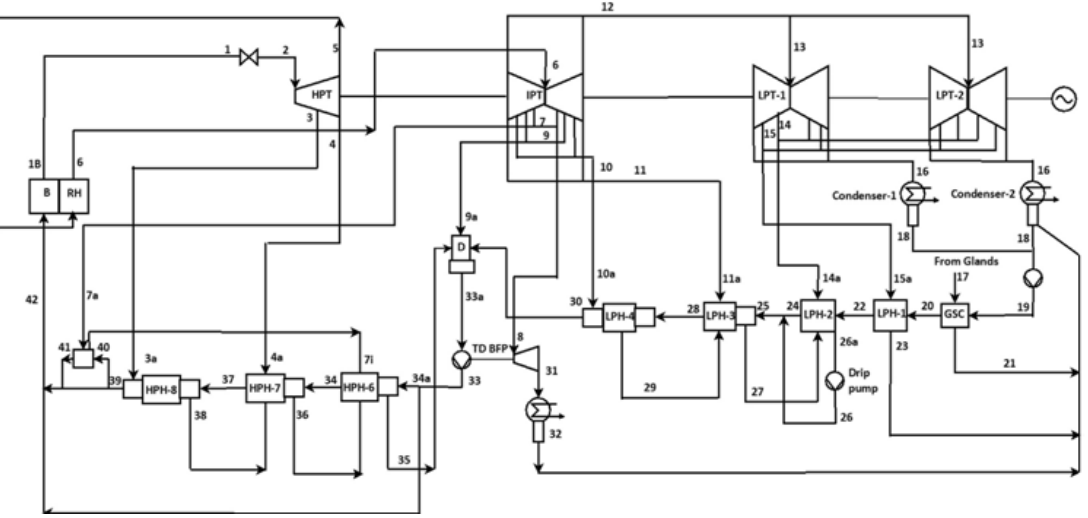
Figure 4. Componential diagram of Supercritical 660 MW thermal power plant.